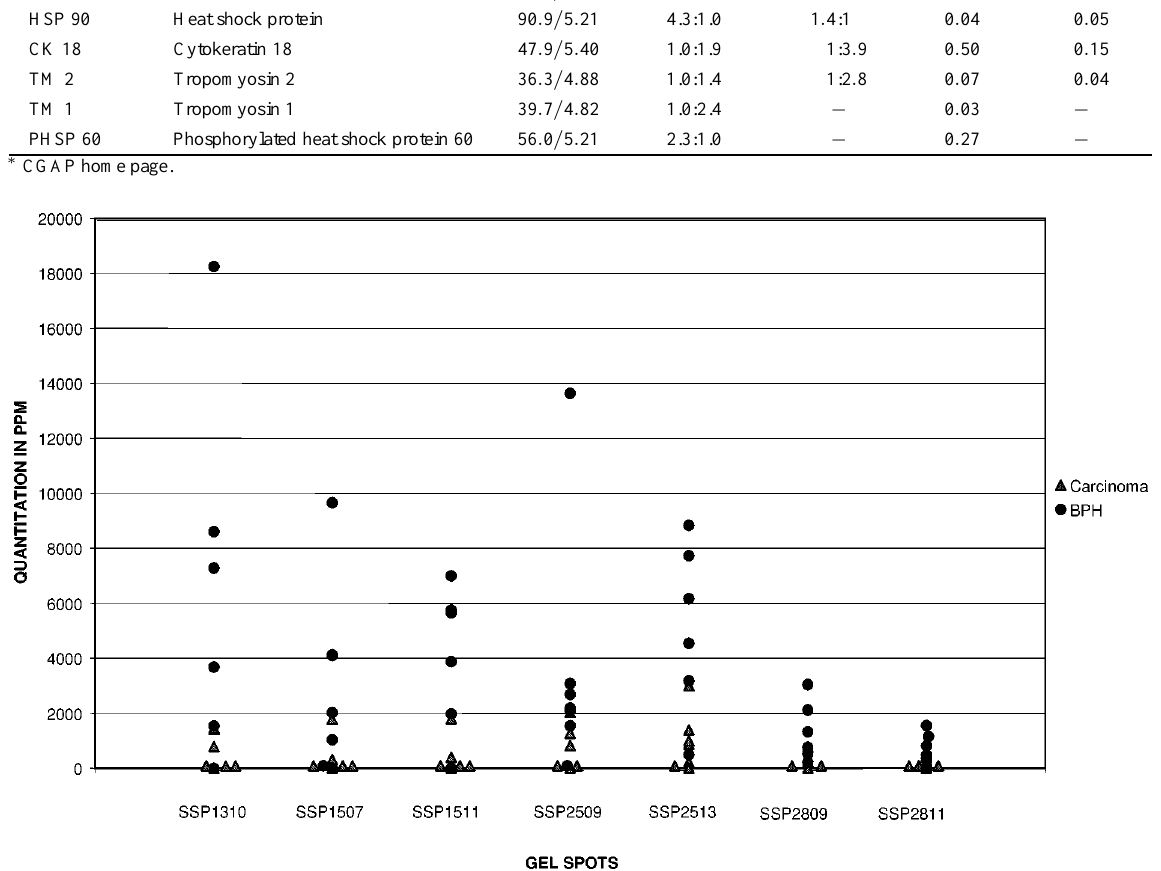
Fig. 3. Expression of 20 spots with significant ( p < 0 : 05) differences between prostate hyperplasia and cancer. The expression level of each individual case is indicated. perplasias and carcinomas were identified. When all the matched spots among individual gels were exam- ined, twenty polypeptides showed more than 2-fold in- creases between carcinomas and benign prostate hy- perplasias (Fig. 3). Due to the limited amount of clini- cal material available, it was not possible to obtain se- quence information from these